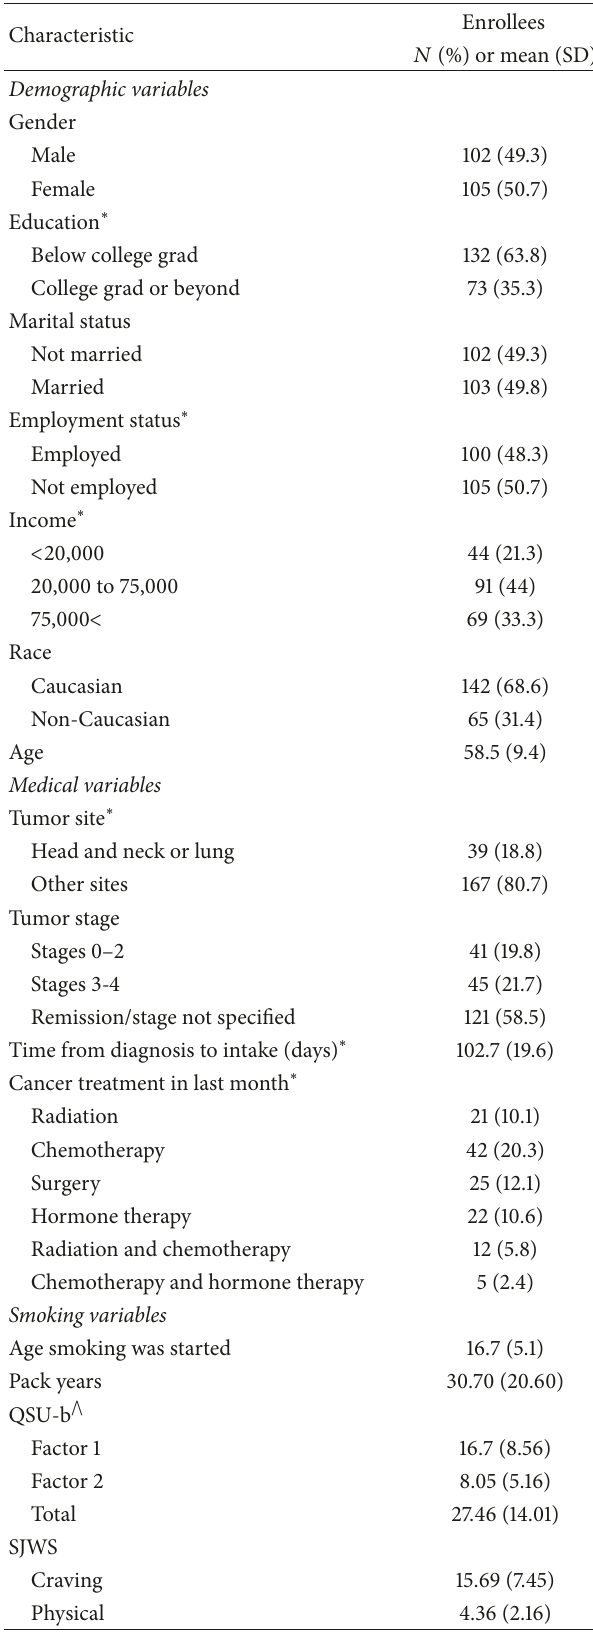
Table 1: Characteristics of program enrollees ( 𝑁 = 207